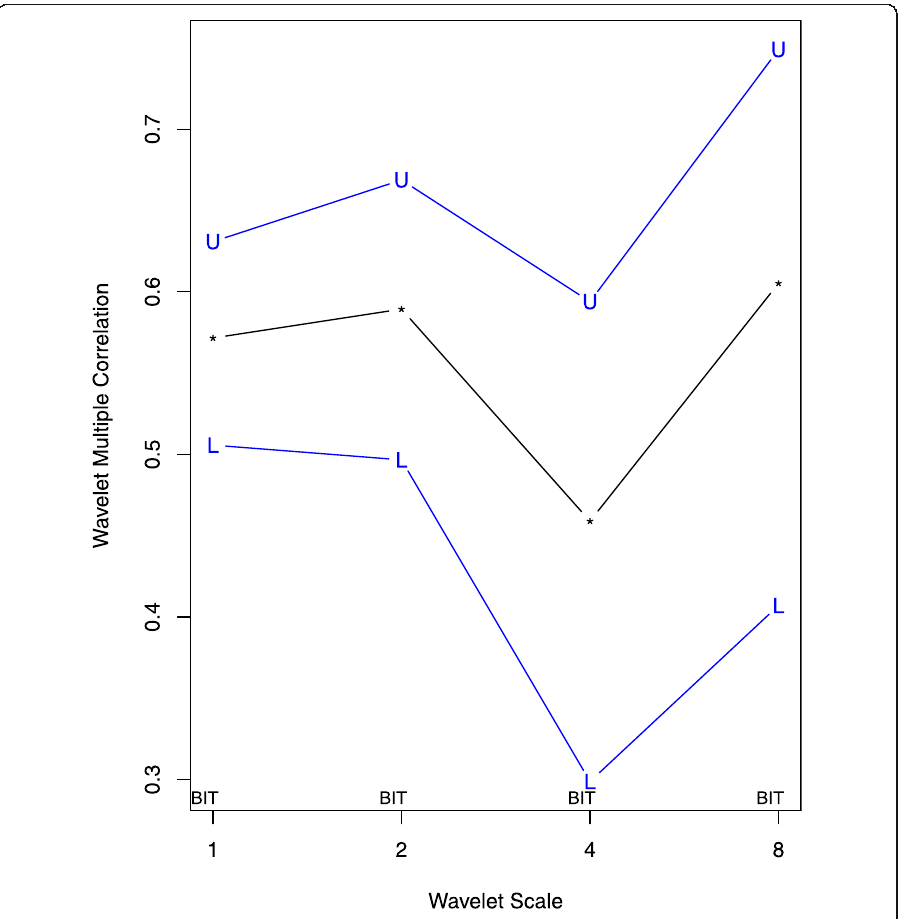
Fig. 2 Wavelet Multiple Correlation of Crypto Currency